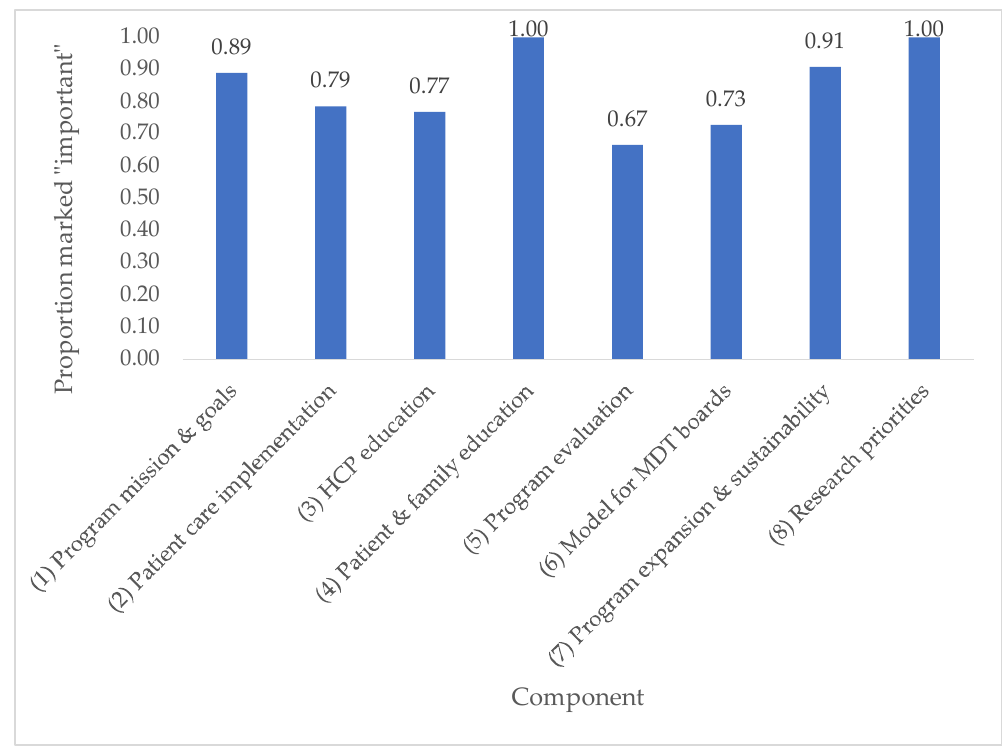
Figure 2. Proportion of items rated “important” per component.